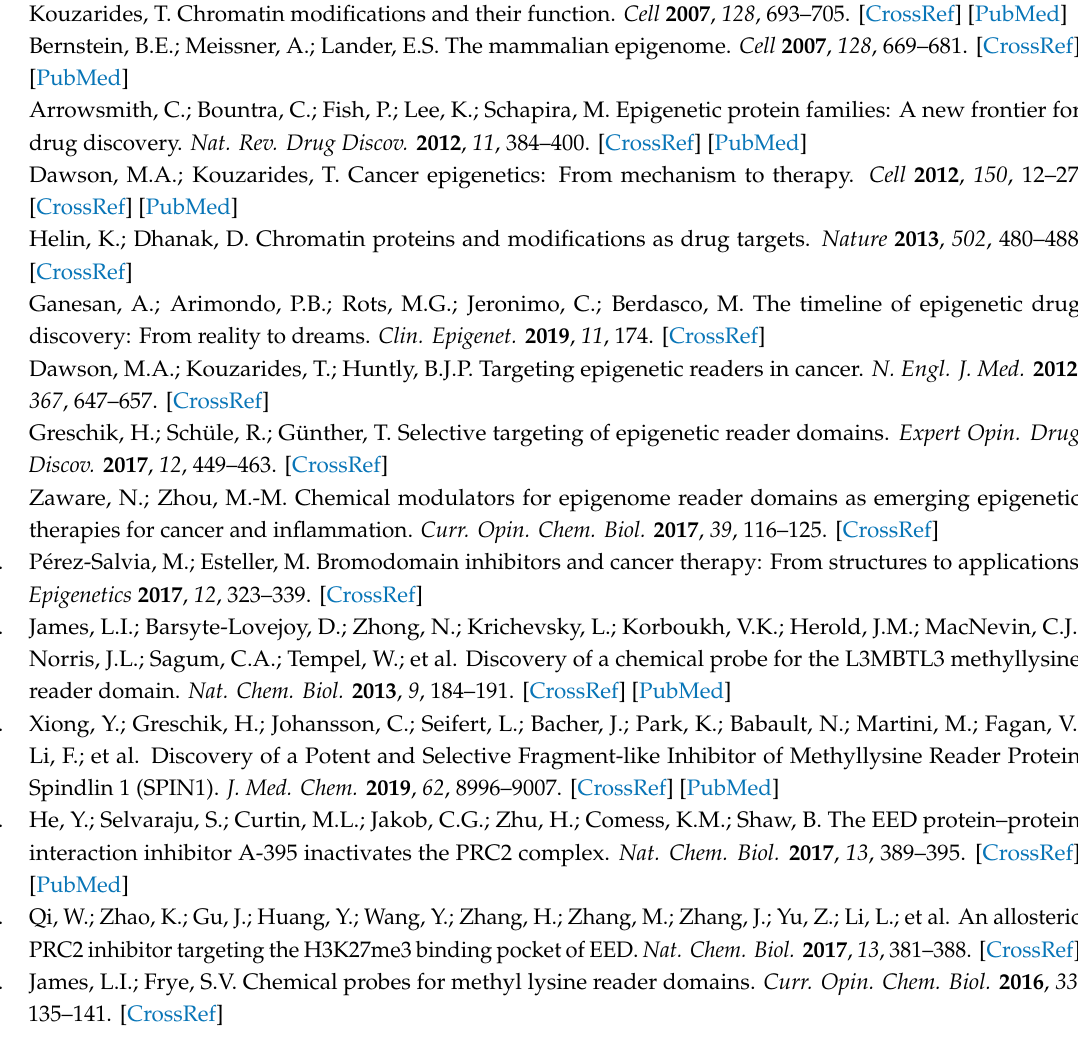
H3K36me3 peptides. Figure S2: Titration data fits for all H3K36me3 peptides. Figure S3: Docking results for the H3E7 complex. Figure S4: Overlay of all peptide-added PSIP1 PWWP